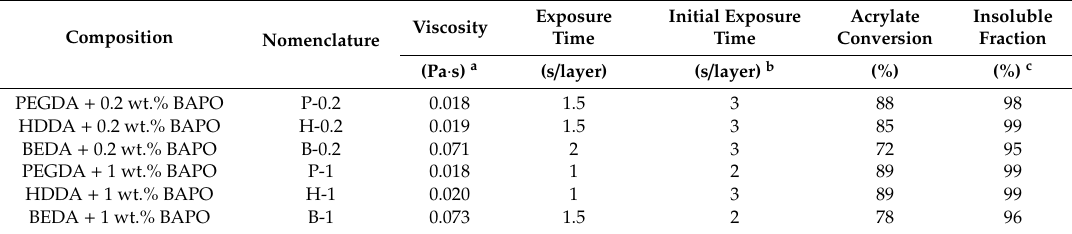
Table 1. Composition and nomenclature of the home-made acrylate resins, average viscosity values at 25 ◦ C, 3D printing settings used for each formulation with a slicing thickness of 50 µ m, insoluble gel fraction (%) and acrylate conversion of the 3D printed